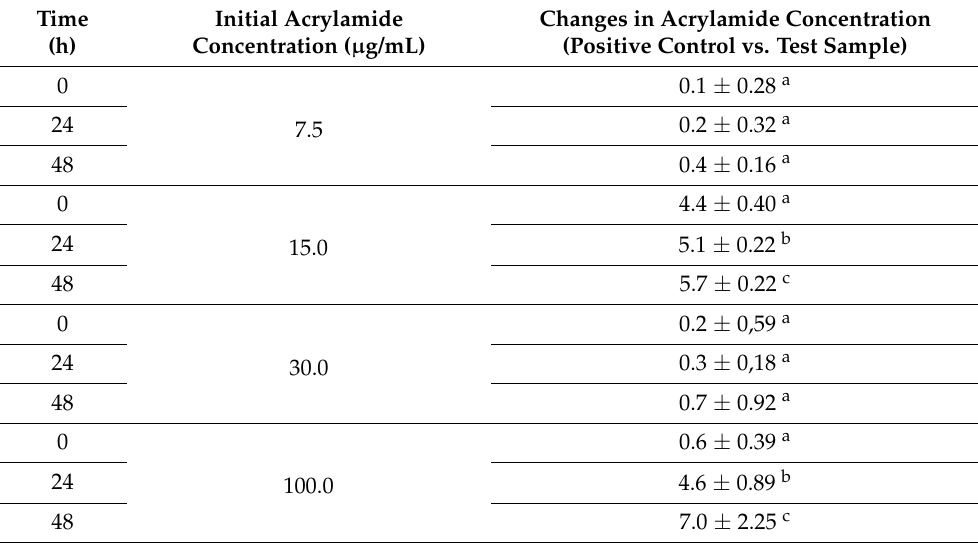
Table 1. The acrylamide degradation caused by Lactobacillus acidophilus LA-5 added to the MRD medium containing various concentrations of acrylamide during incubation ( n =